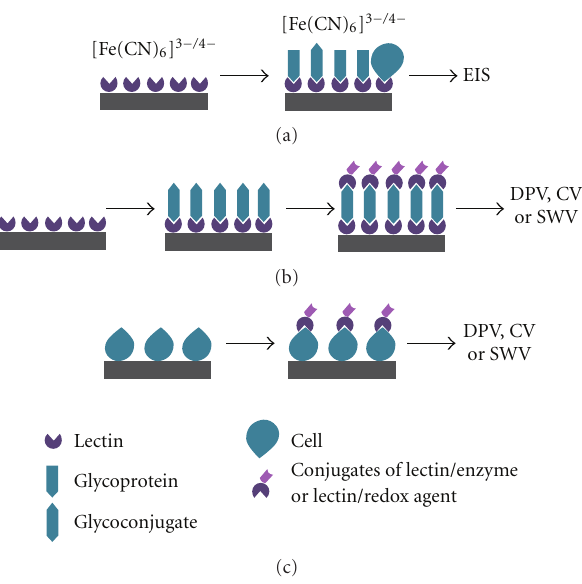
Figure 2: Schematic showing the most common types of elec- trochemical biosensors for glycan analysis: (a) electron impedance spectroscopy-(EIS) based assay; (b) a lectin biosensor sandwich assay using di ff erential pulse voltammetry (DPV), cyclic voltamme- try (CV), or square wave voltammetry (SWV) detection; (c) surface cell carbohydrate assay using a binding lectin/enzyme conjugate to provide the electrochemical signature detected by DPV, CV, or